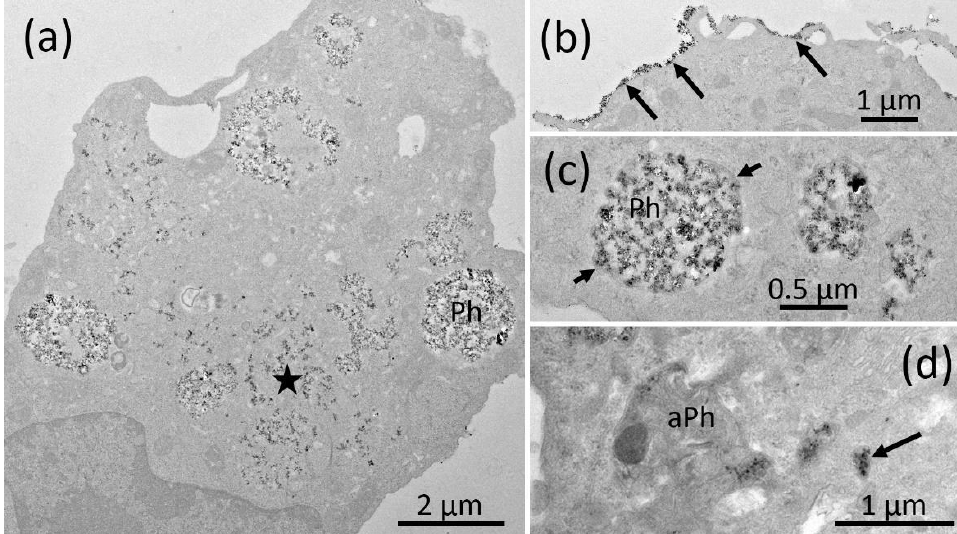
Figure 3. Electron microscopy of NR8383 cells laden with AEROSIL ® 380 F (11.25 µg/mL) in the absence of FCS for 16 h. ( a ) Overview of a cell containing particle filled phagosomes (Ph) and branched particle assemblies in distinct regions of the cytoplasm (asterisk). The cytoplasm of this cell appears condensed. ( b ) Particles adhering to a section of the outer cell membrane (arrows). ( c ) Particle filled phagosomes; arrows point to the enclosing membrane. ( d ) An autophagosome (aPh) filled with condensed matter together with several electron dense lysosomes (arrow); both compartments contain small amounts of the typical, small electron dense AEROSIL ® 380 F particles.